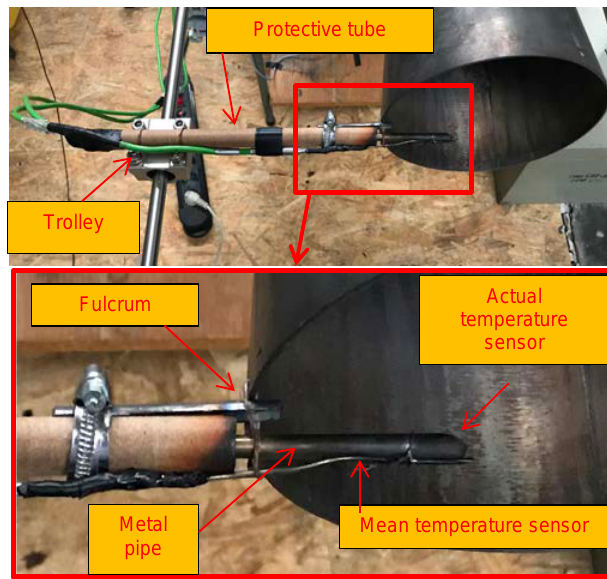
Fig. 3. The view of the system of thermocouples